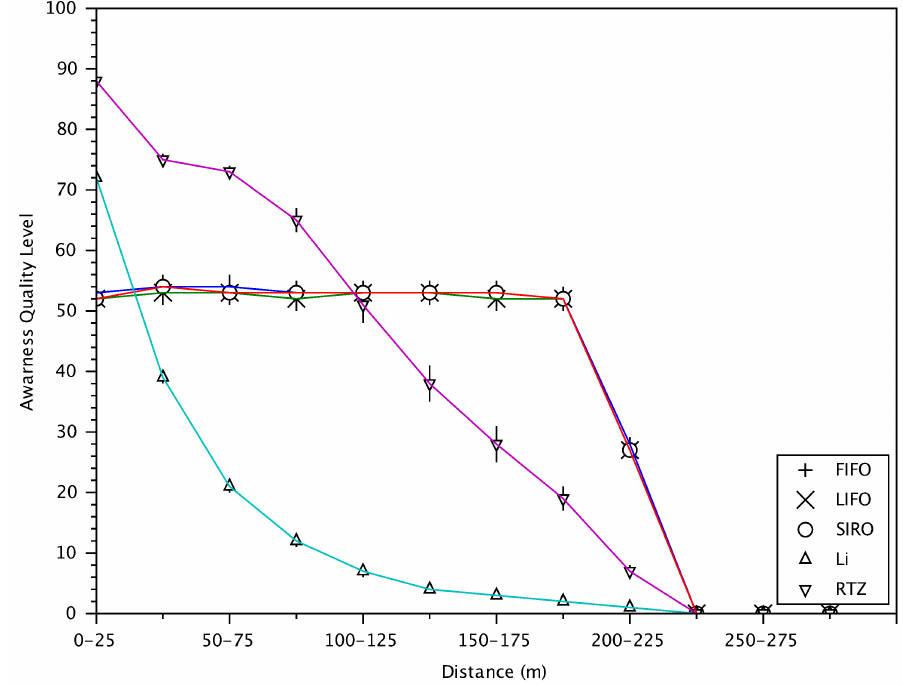
Figure 14. Awareness quality level (AQL) of receiving vehicle with respect to distances between